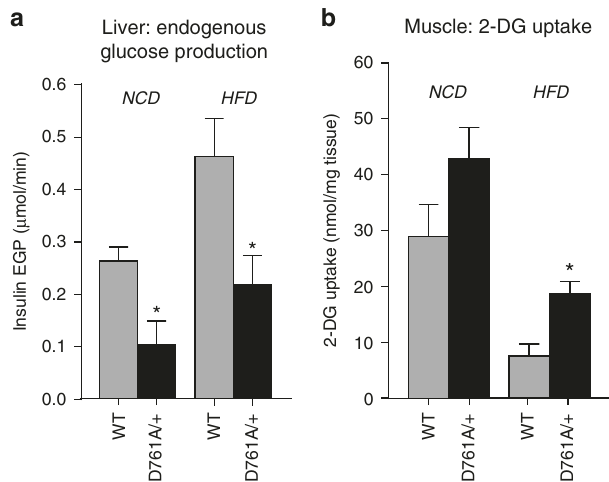
Fig. 4 Impact of Vps34 inactivation on hepatic glucose production and glucose uptake in muscle in vivo. a Endogenous glucose production (EGP) in liver in hyperinsulinemic-euglycemic clamp experiments in WT ( n = 5) and Vps34 D761A/+ mice ( n = 6) under NCD, and in WT ( n = 7) and Supplementary Table 3. Data represent mean ± SEM (non-parametric Mann – Whitney t -test). b 2-Deoxy- D -glucose (2-DG) uptake in muscle in hyperinsulinemic-euglycemic clamp experiments in WT ( n = 3) and Vps34 D761A/+ mice ( n = 6) under NCD, and in WT ( n = 5) and Vps34 D761A/+ mice ( n = 7) under HFD. Data represent mean ± SEM